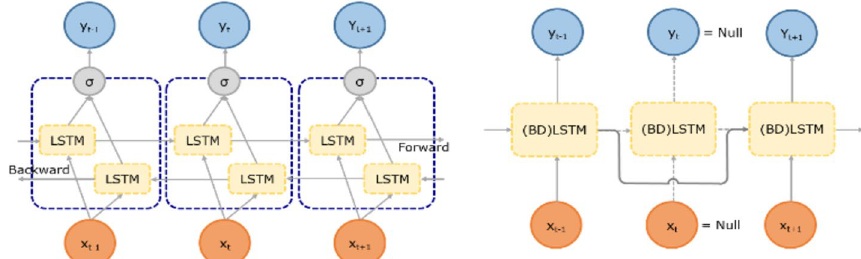
Fig. 17 (Left) Bidirectional LSTM and (right) filter mechanism for processing incomplete data sets